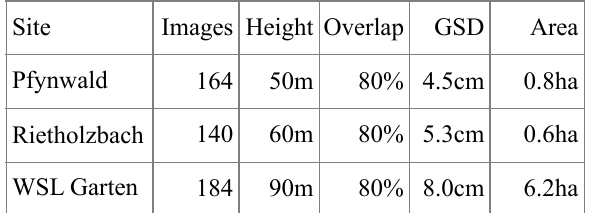
Figure 2. Oblique view of Test site "Pfynwald" with 2 observation platforms.